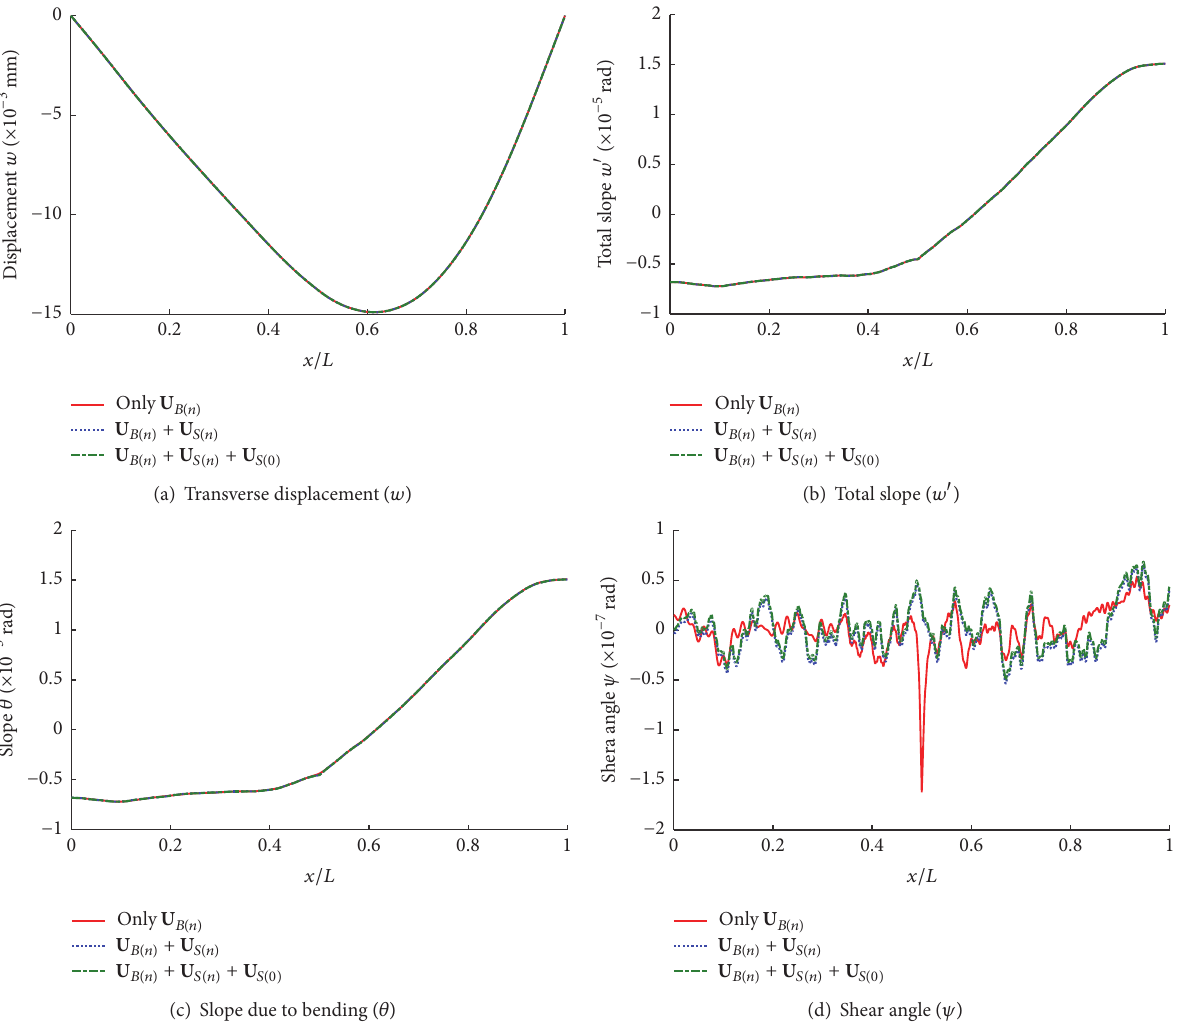
Figure 8: Deformed shapes of a simply supported Timoshenko beam at 𝑡 = 0.5𝑇 𝐴 when the beam is subjected to a point bending moment moving at a constant speed of V 𝜏 = 0.5 V cr : (a) transverse displacement (𝑤) ; (b) total slope (𝑤 󸀠 ) ; (c) slope due to bending (𝜃) ; (d) shear angle (𝜓)